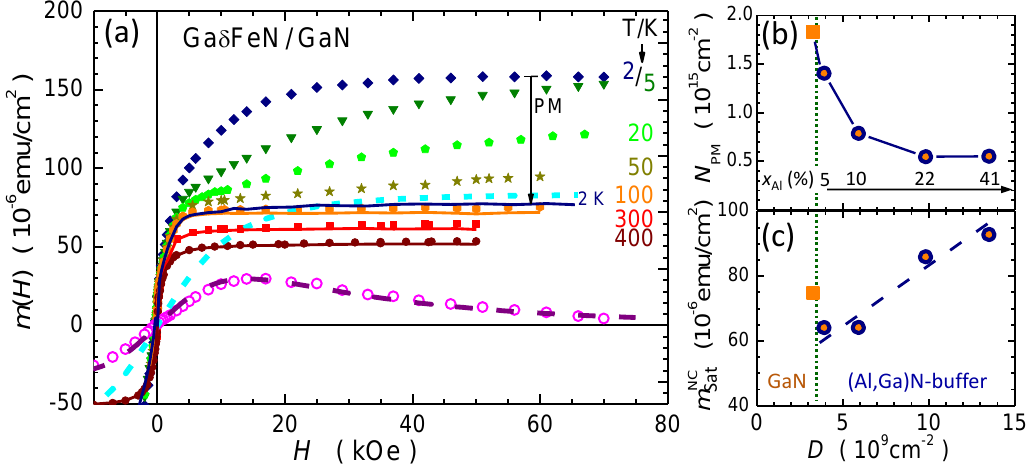
Figure 7. ( a ) (Solid symbols) Isothermal magnetization curves of the reference Ga δ FeN/GaN structure at selected temperatures. The open circles denote the difference ∆ m ( H ) , whereas the dashed line corresponds to the calculated difference of the respective Brillouin functions calculated for the paramagnetic Fe 3 + ions with N PM = ( 1.8 × 10 15 ) cm − 2 . The solid lines mark the resulting magnitudes of m NC ( H ) of the NCs, after subtracting the paramagnetic component. The solid down–arrow indicates the degree of the reduction of m ( H ) due to the subtraction of the paramagnetic contribution. ( b , c ) N PM and m sat plotted as a function of total dislocation density D . The squares represent the reference NC Ga δ FeN/GaN structure, the circles mark data for the layers grown on the Al x Ga 1 − x N buffers. The corresponding concentration of Al in the Al x Ga 1 − x N buffers is indicated in panel ( b ). Dashed lines in panels ( b , c ) are guide to the